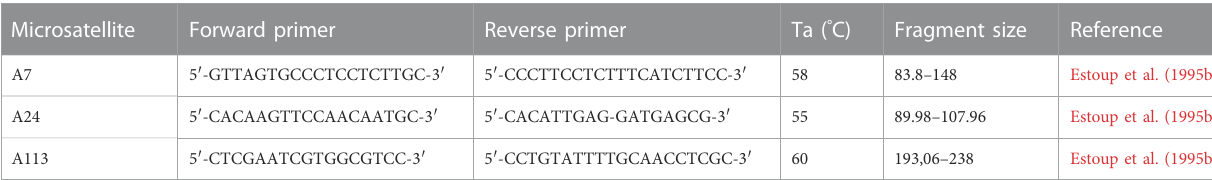
TABLE 1 Microsatellite loci used in this